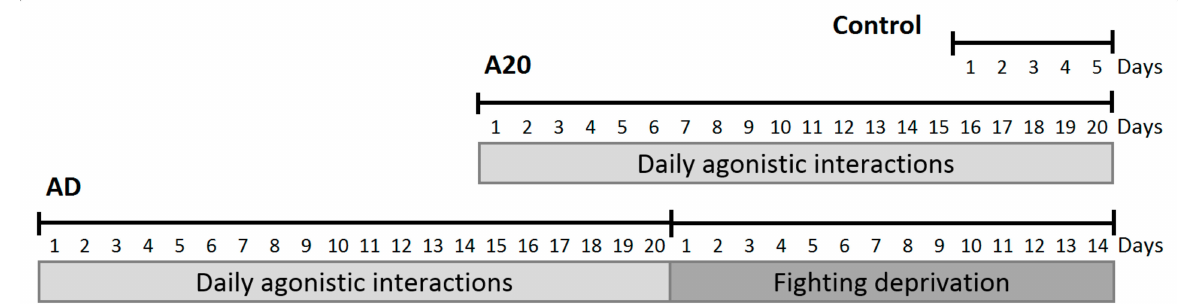
Figure 1. Timescale of experiments. A20—mice with 20 days of consecutive wins in daily agonistic interactions; AD—A20 mice after subsequent 14 days of fight deprivation; Control—mice without agonistic